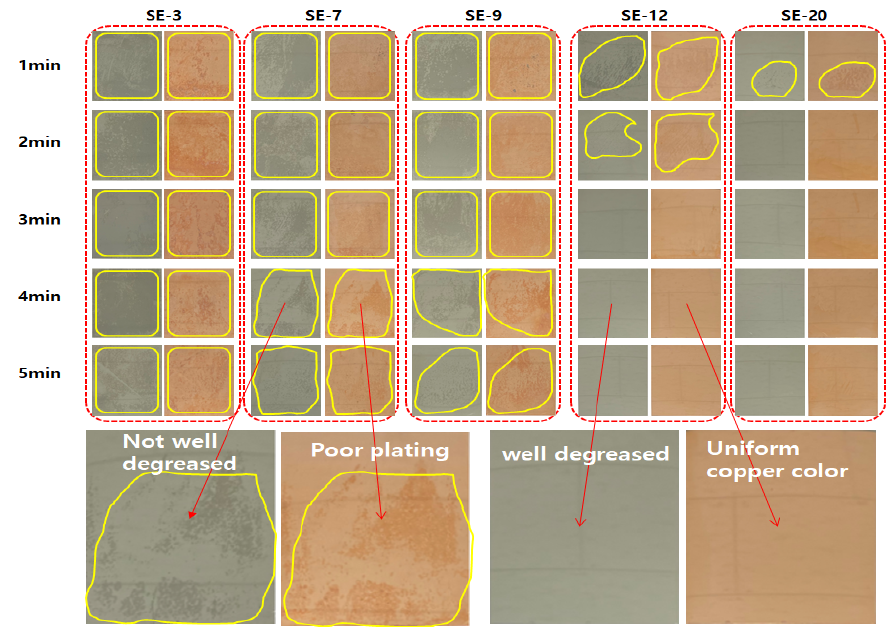
Figure 5. Images of degreased specimens before ( left ) and after ( right ) Hogaboom tests as a function of degreasing time at 80 °C.